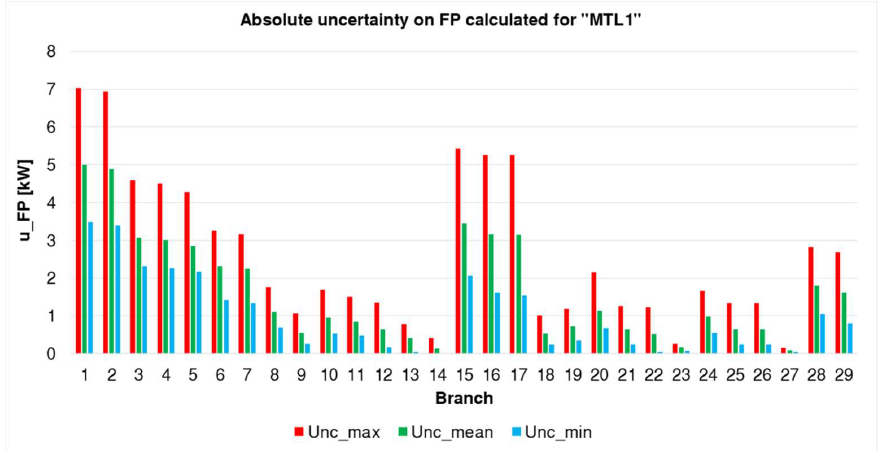
Figure 15. Maximum, average and minimum values of the absolute uncertainties in the calculated active power flows of the “MTL1” line (31 May 2018).